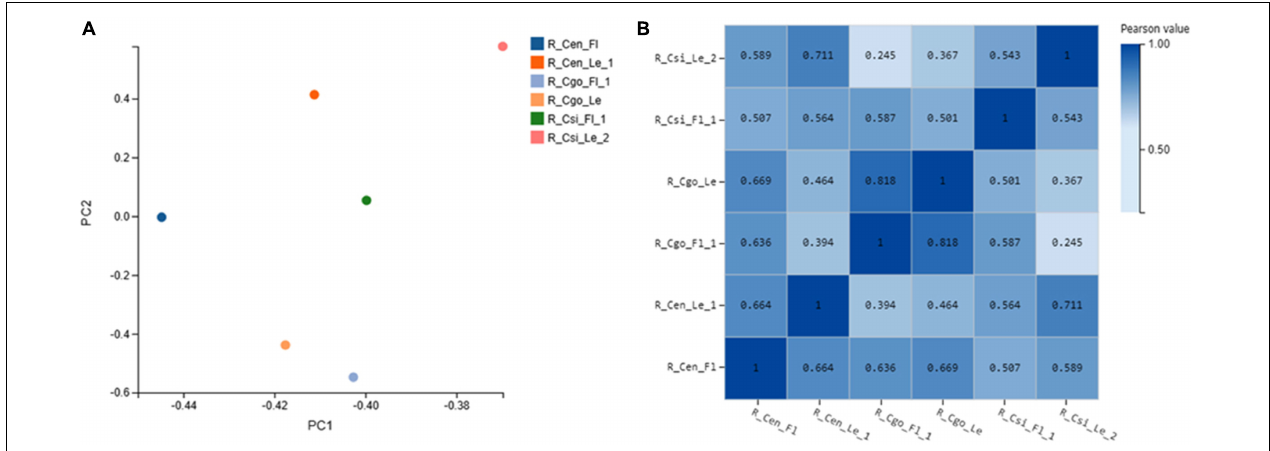
FIGURE 1 | Principal component analysis (PCA) (A) ; and Pearson’s correlation analysis (B) , both X - and Y -axes represent each sample. The color represents the correlation coefficient (the darker the color, the higher the correlation, and the lighter the color, the lower the